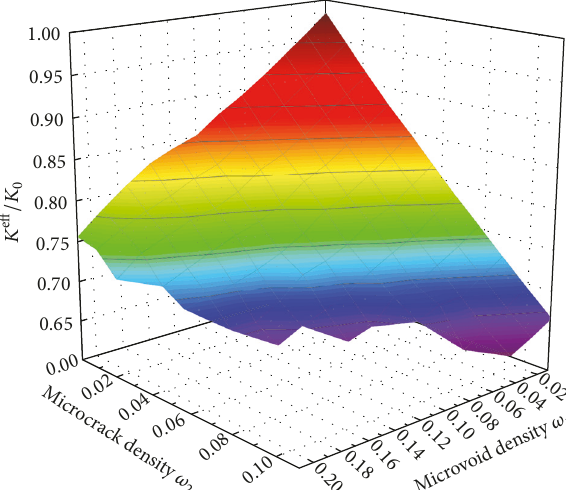
Figure 12: 𝐾 eff /𝐾 0 versus the microcrack’s and microvoid’s density.